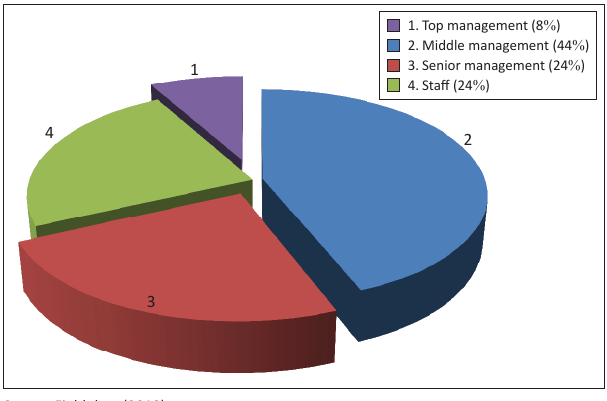
FIGURE 1: Pie chart showing respondents’ organisational levels.